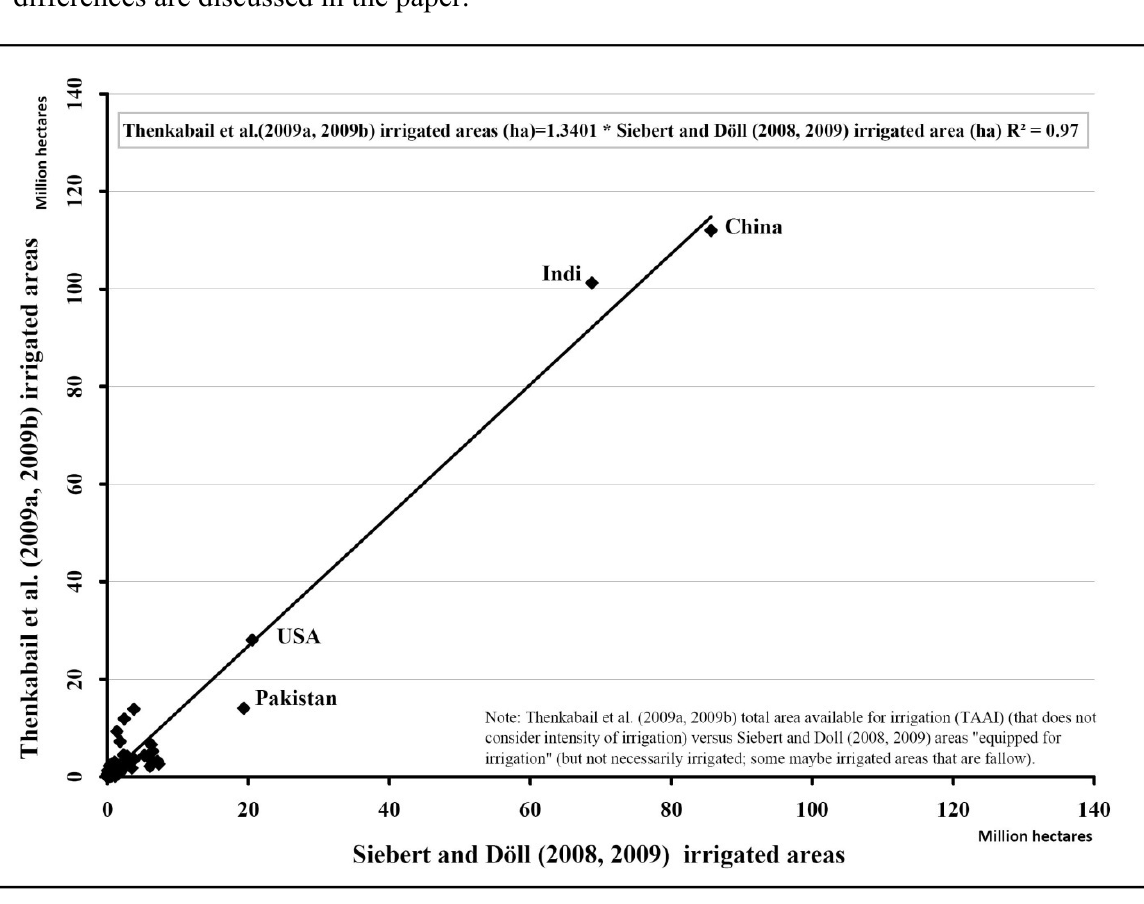
Figure 6b. Comparison of irrigated areas. Irrigated areas derived by Siebert and Döll [49] and national statistics provided by Ministry of Agriculture [68] based primarily on remote sensing approaches. The Thenkabail et al . [69] estimates were significantly higher than Siebert et al . [52] mainly as a result of the huge differences for India and China. Overall, there is remarkably high correlation (R 2 value of 0.97) for the 1:1 line for a country-by- country comparison of irrigated cropland areas between the two approaches. However, the differences are lower than Figure 6a mainly due to revised irrigated areas reported for China and India by Siebert and Döll [49] compared to Siebert et al . [52]. Reasons for differences are discussed in the